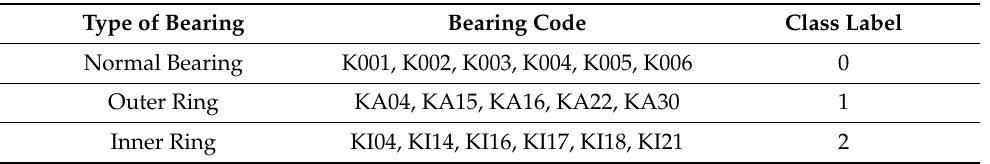
Table 2. Bearing data considered for analysis.